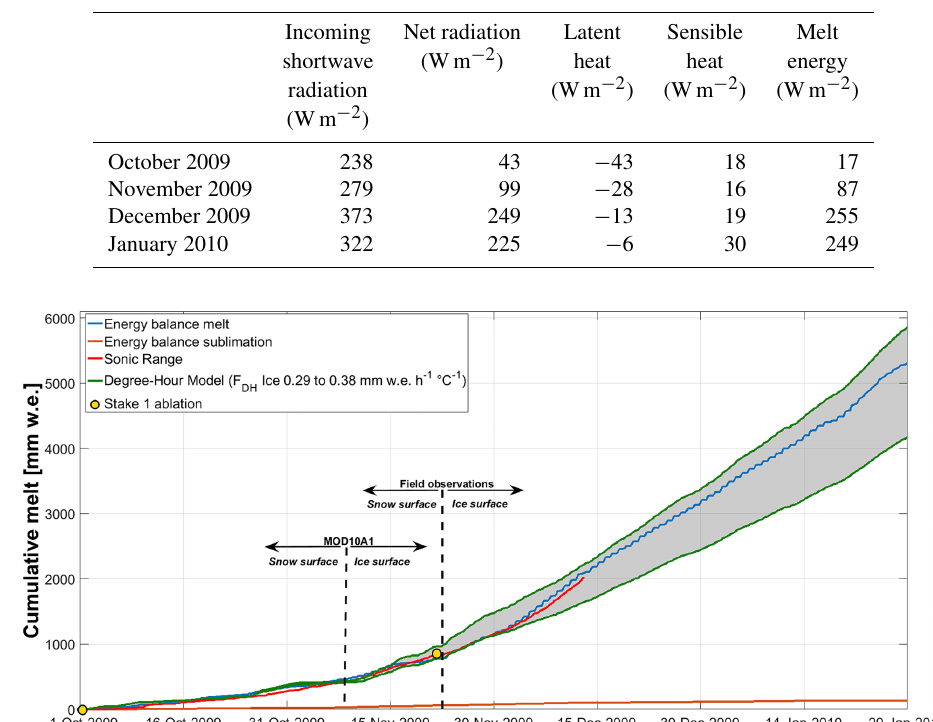
Table 2. Mean monthly energy fluxes at AWS1.